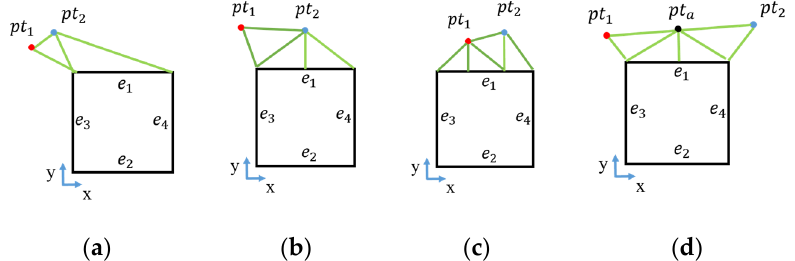
Figure 9. Connection rule: ( a ) type 1, ( b ) type 2, ( c ) type 3, and ( d ) type 4. pt a is the midpoint of two